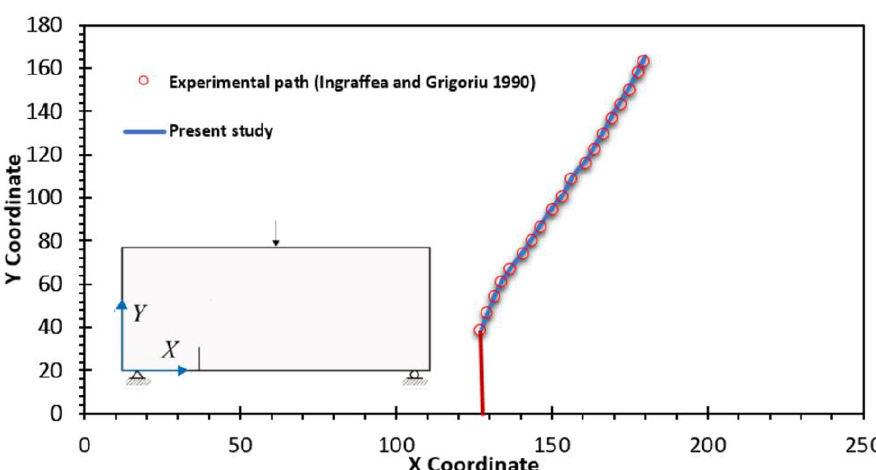
Figure 13. Predicted crack growth path for specimen 4.